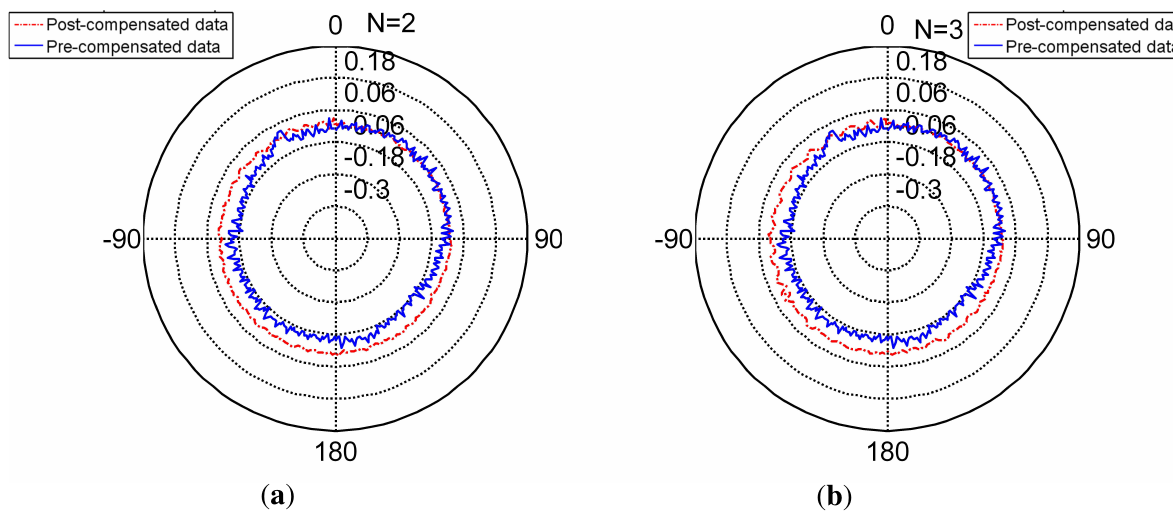
Figure 10. Compensation for separating factor two and three. ( a ) separating factor two; ( b ) separating factor